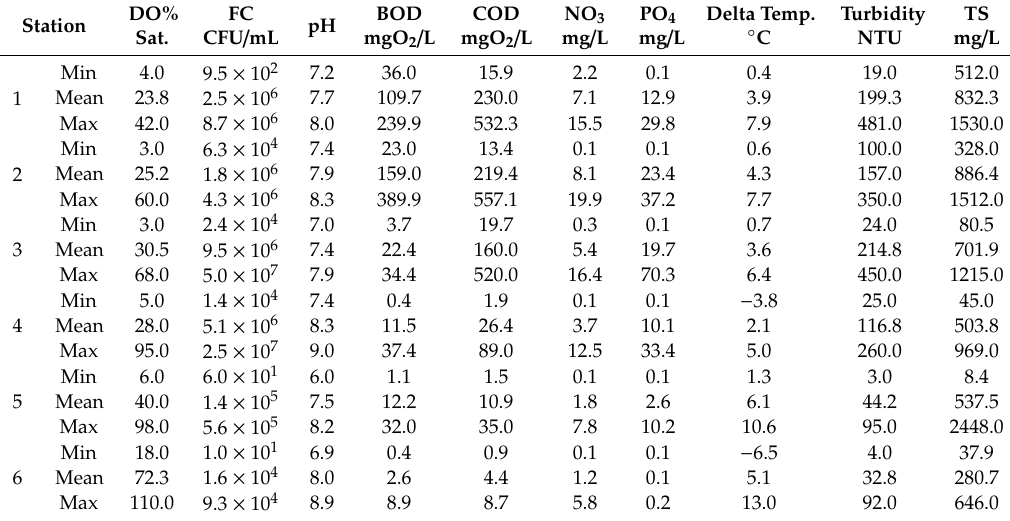
Table 7. Range and mean value of di ff erent water quality parameters at measuring stations 1–6, including their corresponding upstream sampling sites: dissolved oxygen (DO), faecal coliforms (FC: colony-forming units (CFU)), pH, biological oxygen demand (BOD), chemical oxygen demand (COD), nitrates (NO 3 ), phosphates (PO 4 ), delta temperature, turbidity, and total solids